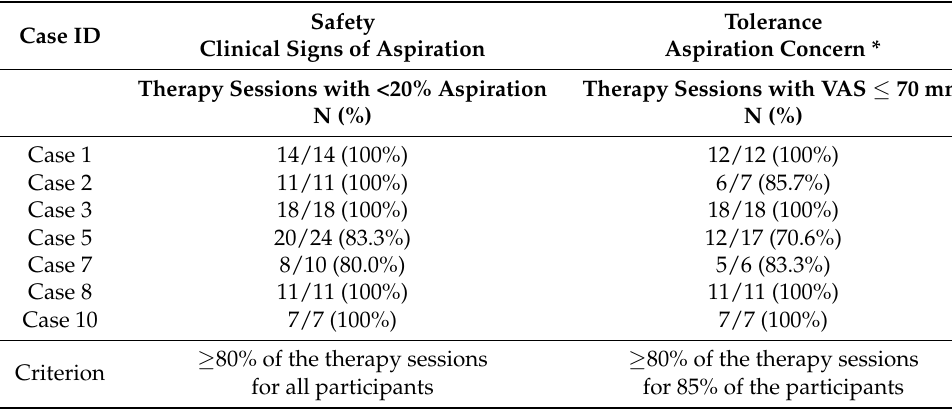
Table 4. Feasibility marks: safety and tolerance during intervention.